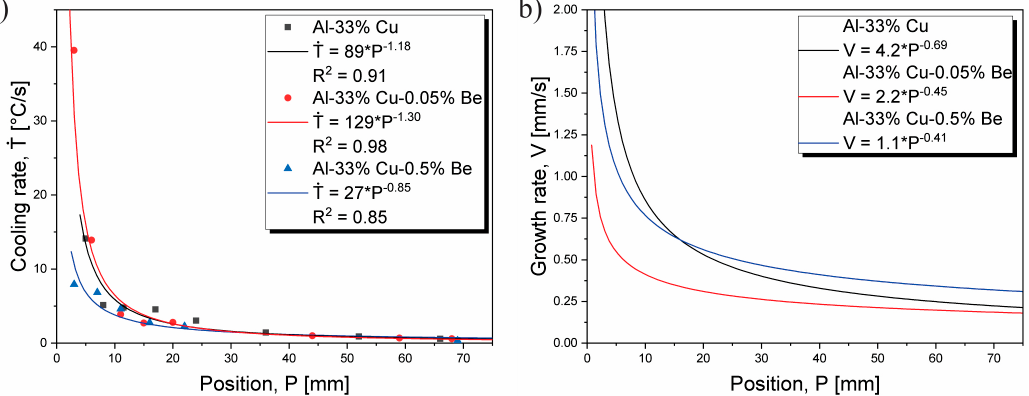
Figure 4. ( a ) Cooling rate and ( b ) growth rate as functions of position from metal/mold interface for Al-33 wt.%Cu date from [19], Al-33 wt.%Cu-0.05 wt.%Be and Al-33 wt.%Cu-0.5 wt.%Be